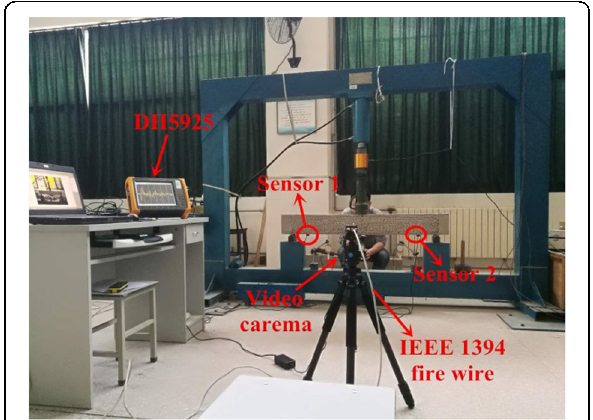
Fig. 7 Overview of the laboratory loading and measurement test